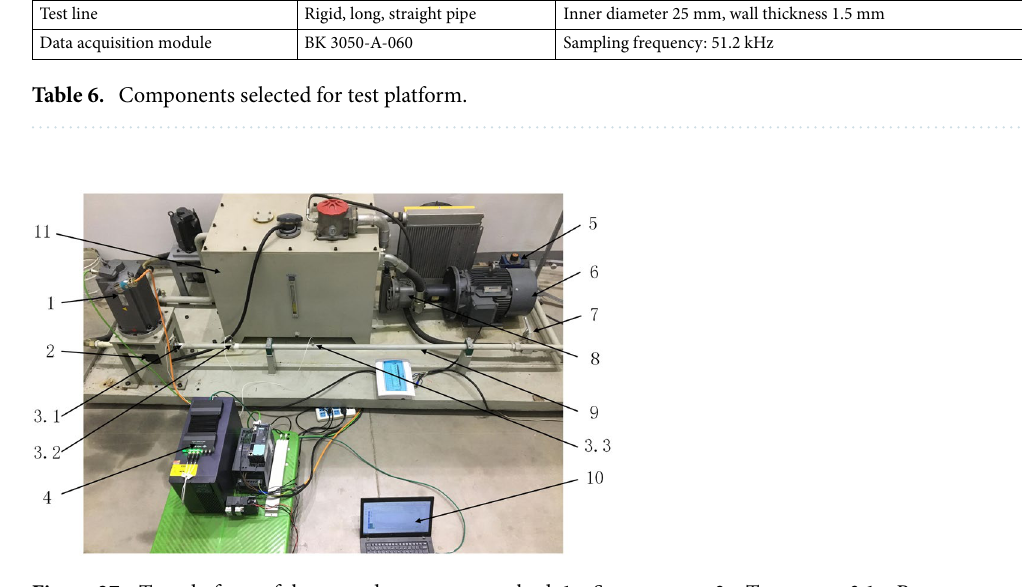
Figure 27. Test platform of the secondary source method: 1—Servo motor; 2—Test pump; 3.1—Pressure transducer No. 1; 3.2—Pressure transducer No. 2; 3.3—Pressure transducer No. 3; 4—Data acquisition